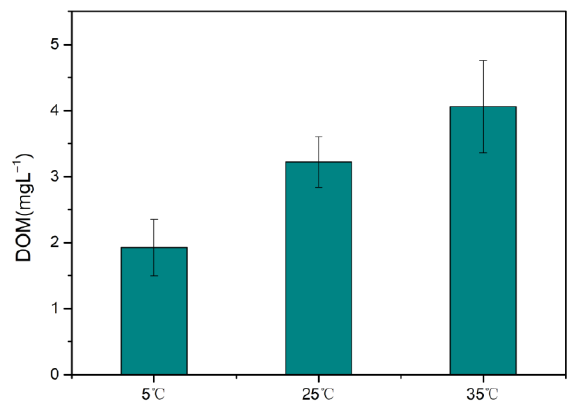
Figure 4. DOM in soil at different temperatures.